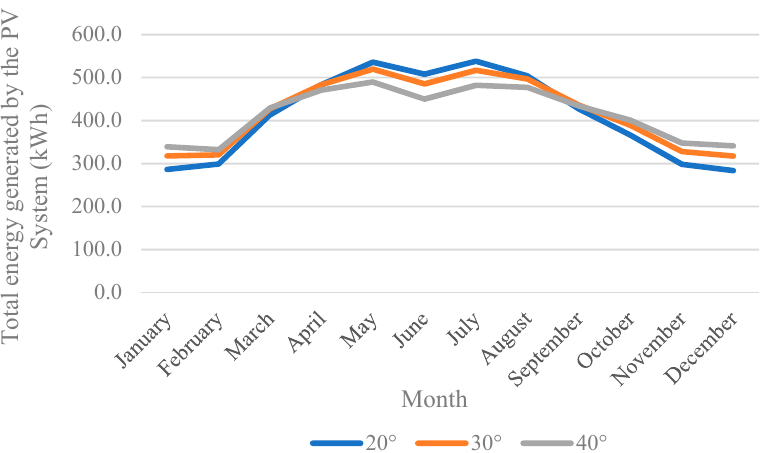
Figure 2. Comparison of the monthly electricity generation of a south-facing 3 kWp PV system with 20 ◦ , 30 ◦ and 40 ◦ inclination angles.